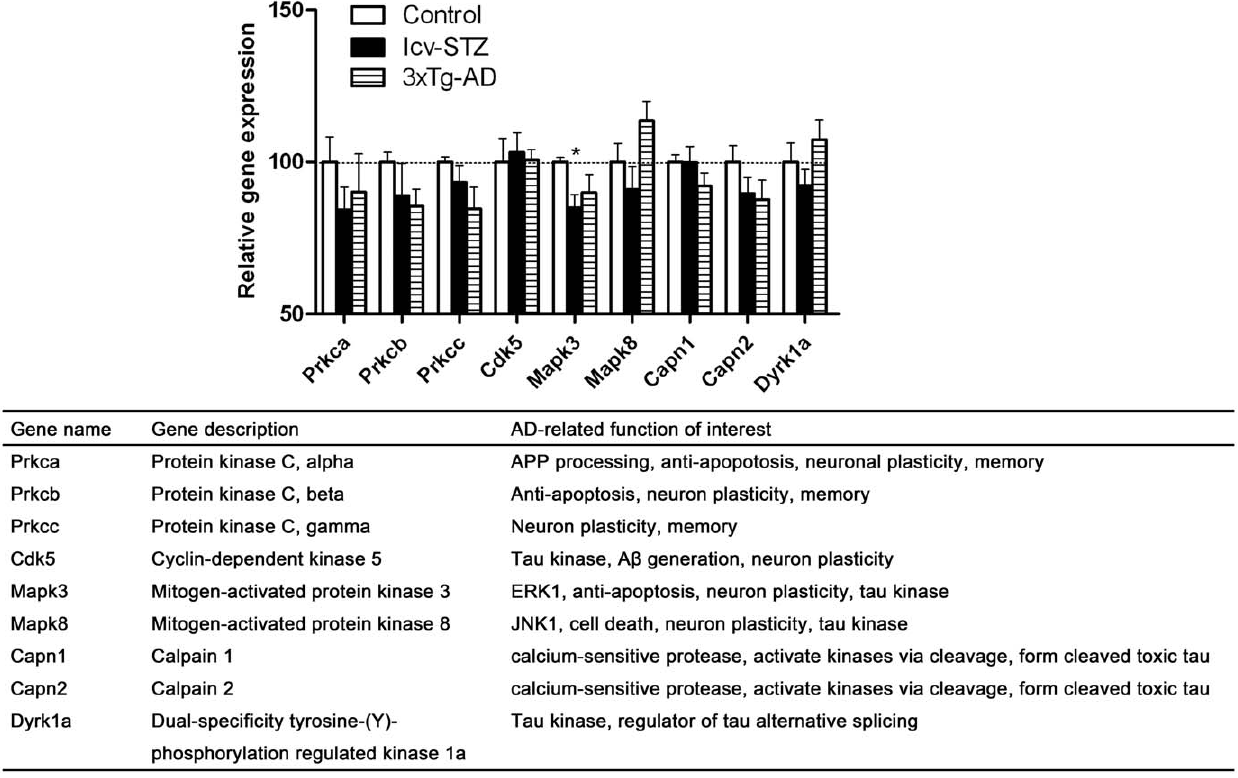
Figure 6. Gene expressions of AD-related protein kinases in the hippocampus.